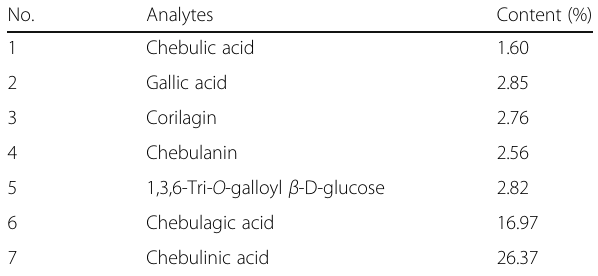
Table 1 Proportion of the seven TCE constituent compounds a